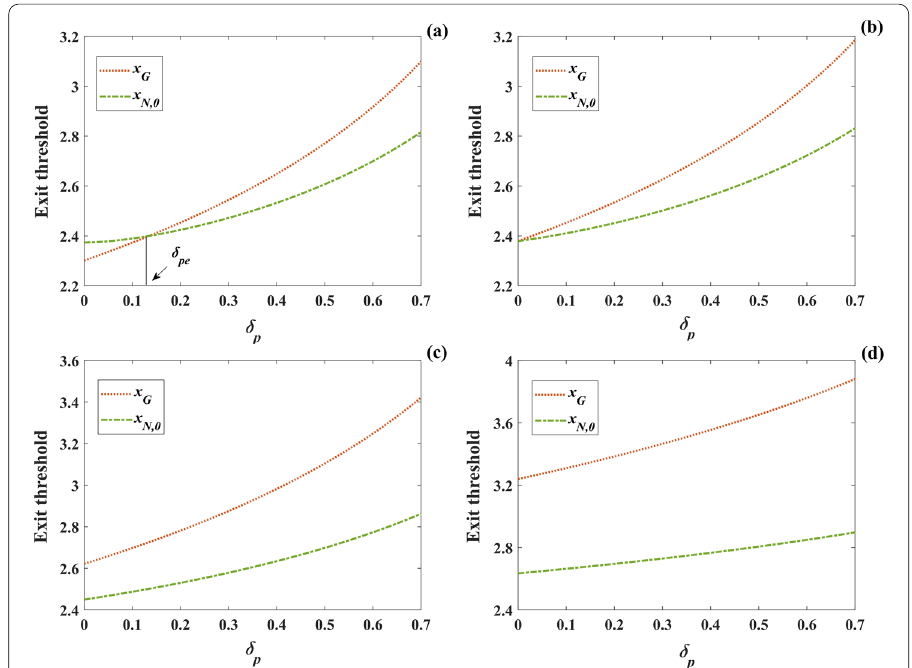
Fig. 6 Exit thresholds change with the reduction factor δ p under (cid:31) f = (cid:31) pN . The parameter values are (cid:31) f = 1 , a (cid:31) 0.8 , b (cid:31) 0.5 , c (cid:31) 0.2 , and d (cid:31) pN = pN = pN = pN =